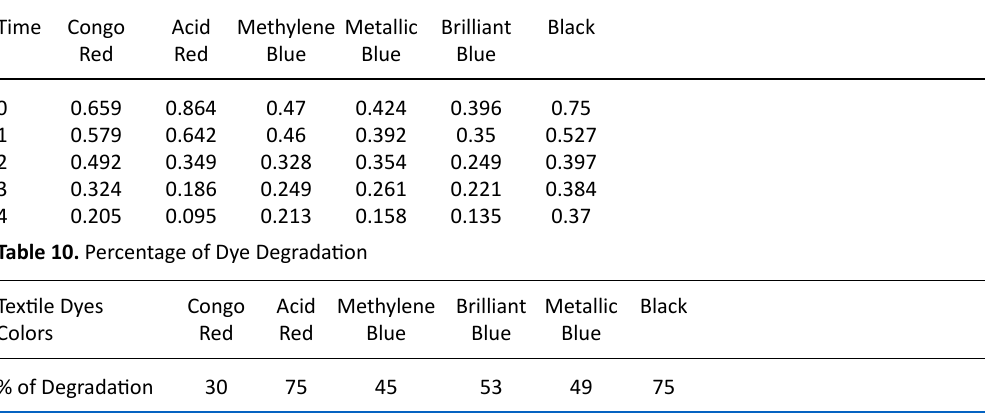
Table 9. Absorbance of the dyes after Treatment